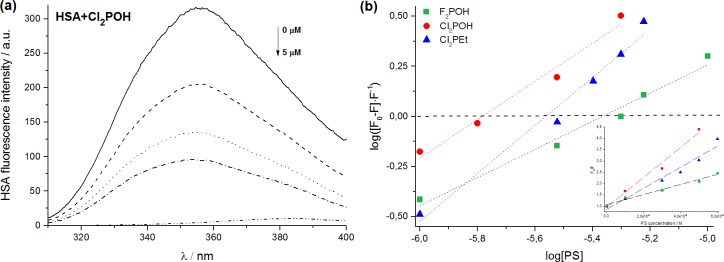
(a) Fluorescence spectra of HSA in the presence of various PS concentrations, (b) Scatchard analysis performed for PS-HSA interaction and Stern-Volmer plots (inset).